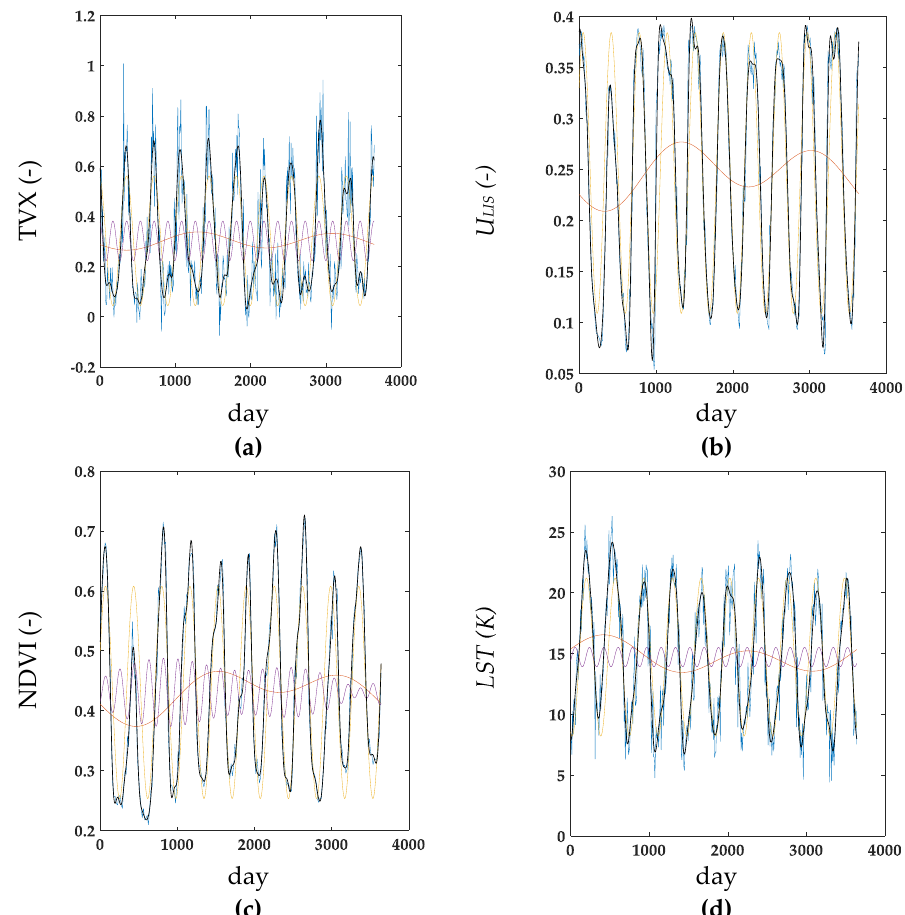
Figure 10. Signals harmonics (the frequency components in y-axis) in the time domain (the cumulative days starting from 01 / 01 / 2001 in x-axis): ( a ) TVX ; ( b ) U LIS ; ( c ) NDVI , and ( d ) ∆ LST . The 0 harmonic is shown in the red line, the 1 harmonic in yellow, and the 2 harmonic in purple. Table 1. Variables’ main harmonics: frequencies and times. For the harmonic “0” no peak frequency was reported since a zero-shift FFT algorithm was